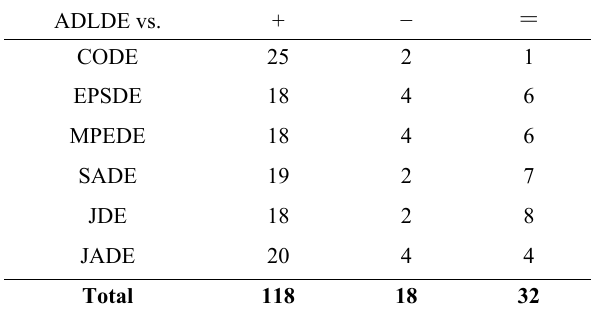
Table 7 Summary of function error values when D = 30. ADLDE vs.